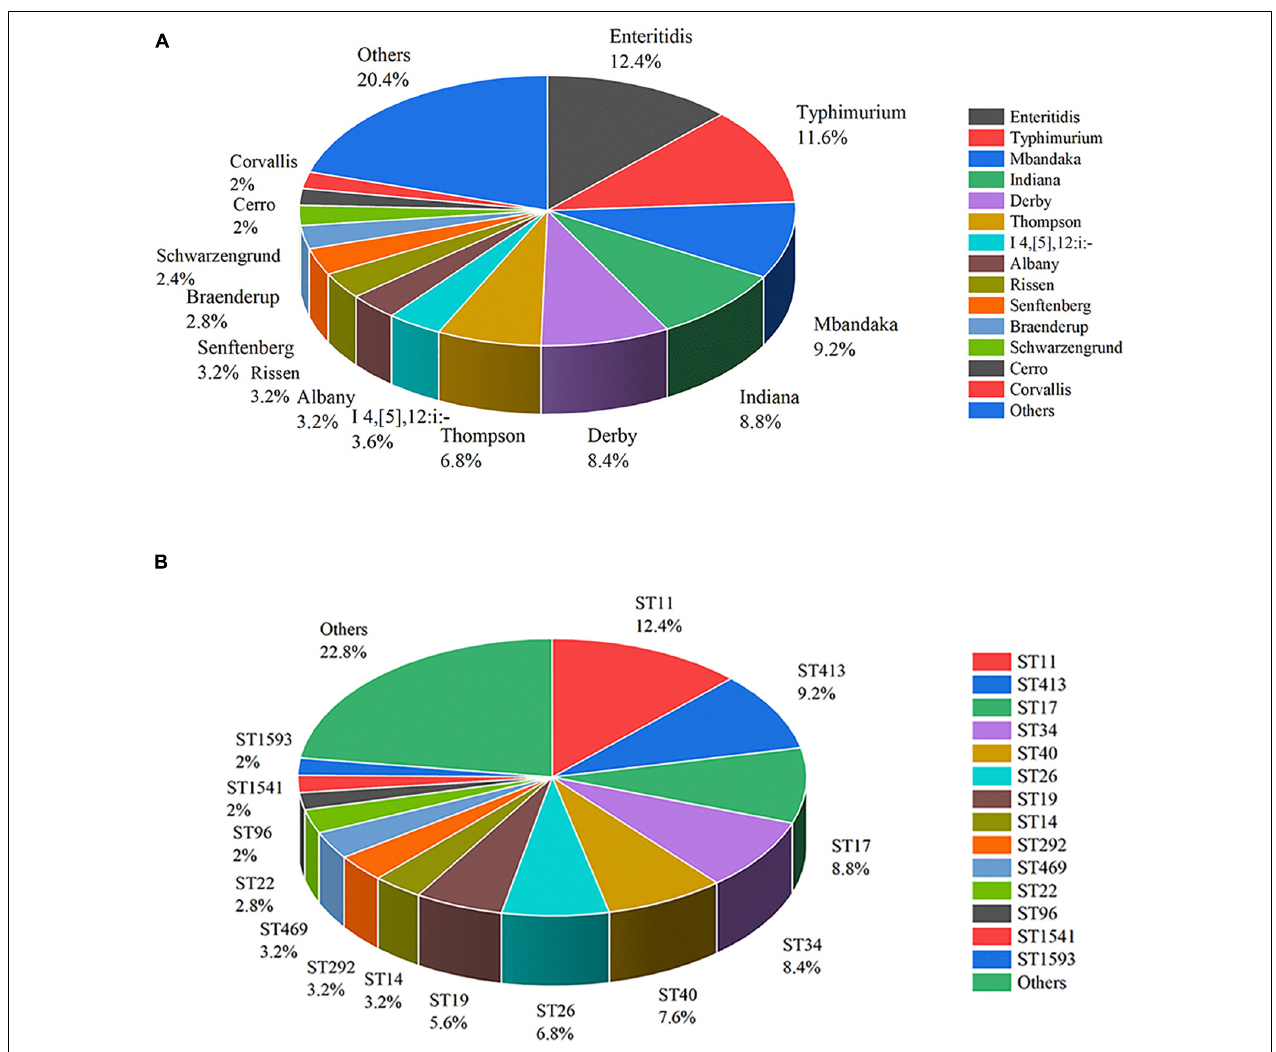
FIGURE 2 | Distribution of Salmonella enterica isolates of serotypes (A) and STs (B) .